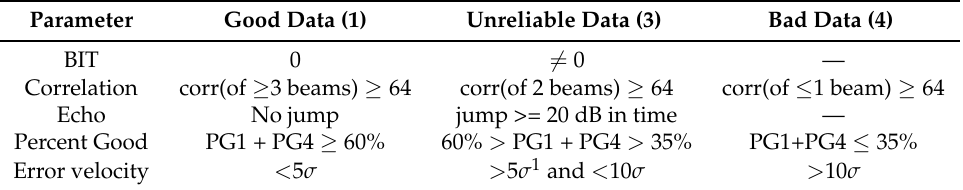
Table 1. Threshold values used for ADCP (Acoustic Doppler Current Profiler) quality control.